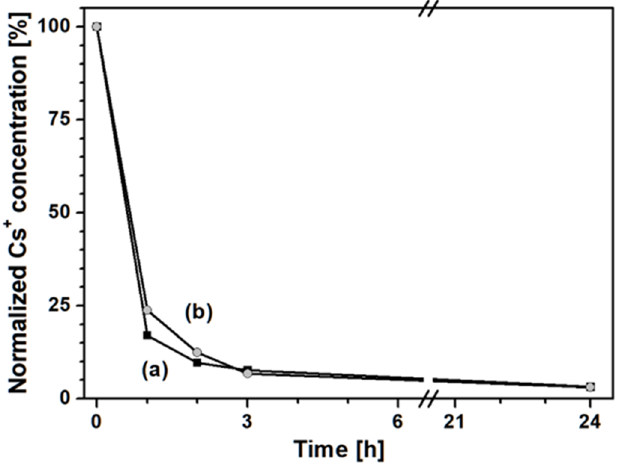
Figure 7. Normalized Cs + concentration in gastric fluid after contact with PB_Syn ( ■ , a ) and PB_Acid ( • , b ) samples. A break from 6 h to 21 h is reported in the graph.